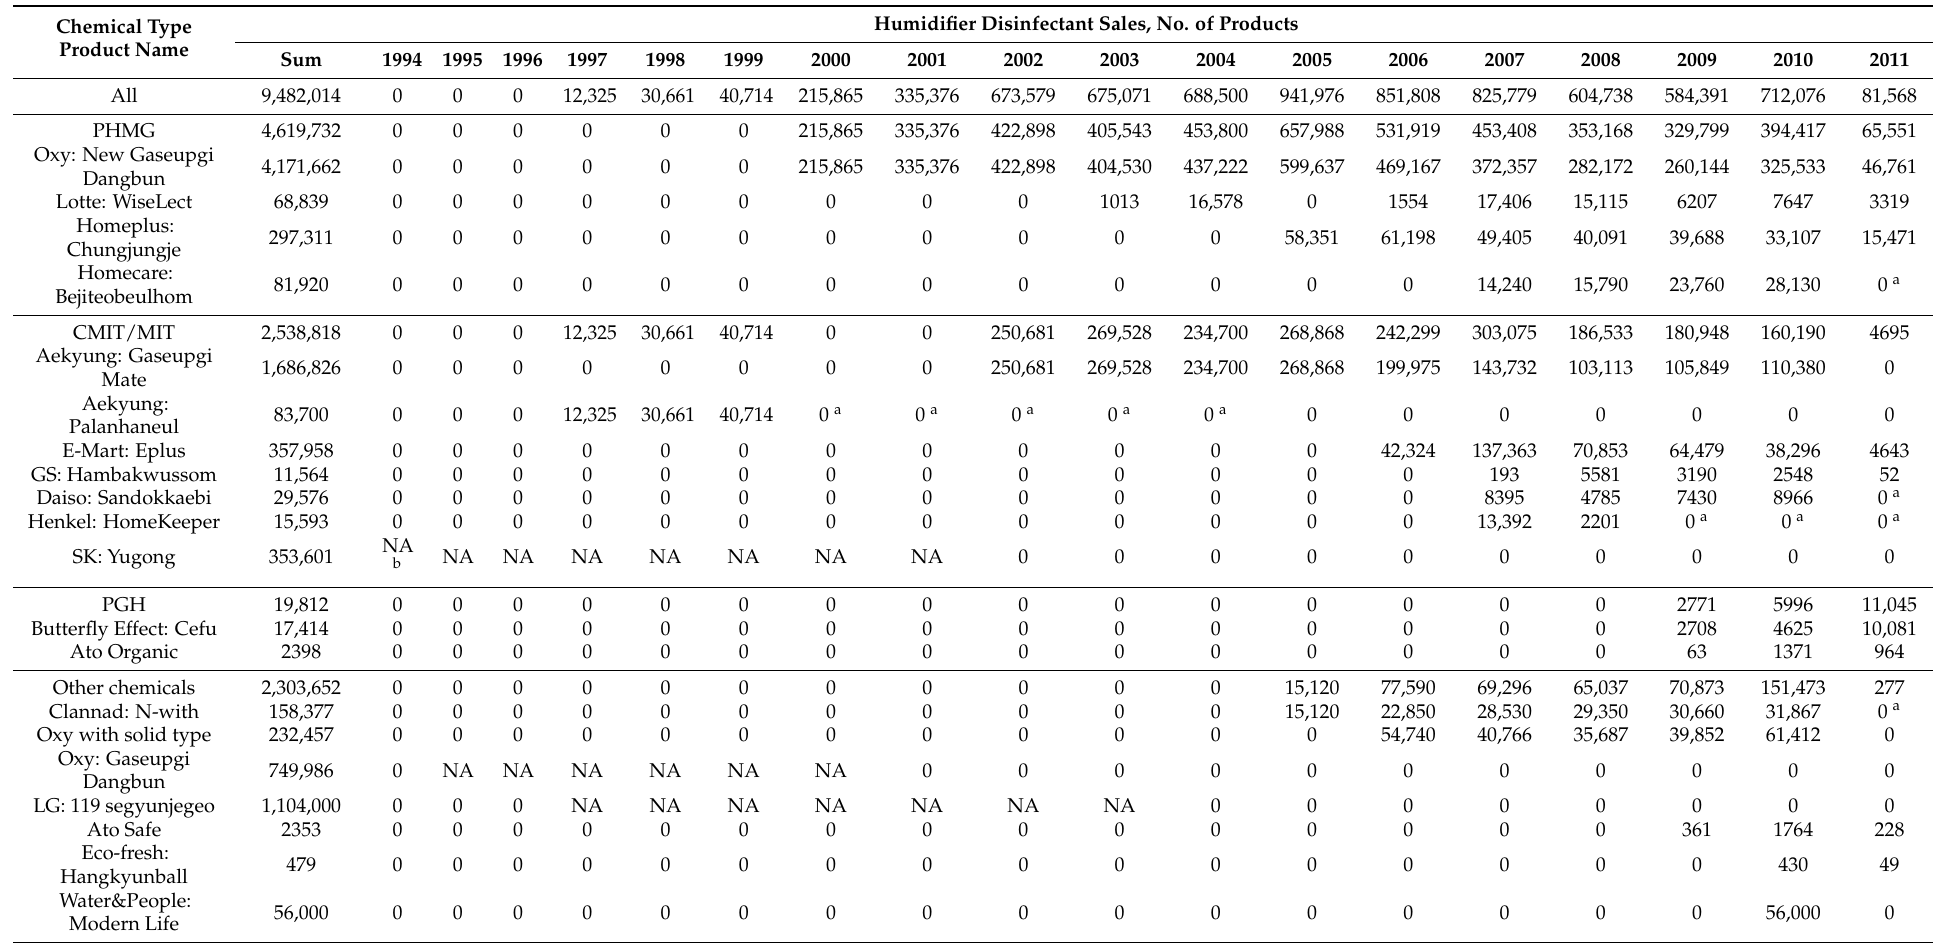
Table 1. Annual sales of humidifier disinfectants during